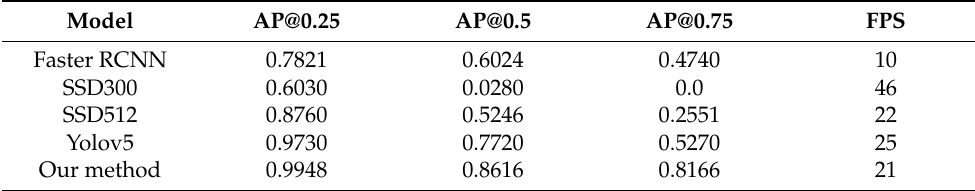
Table 2. Comparison with SOTA under image-level